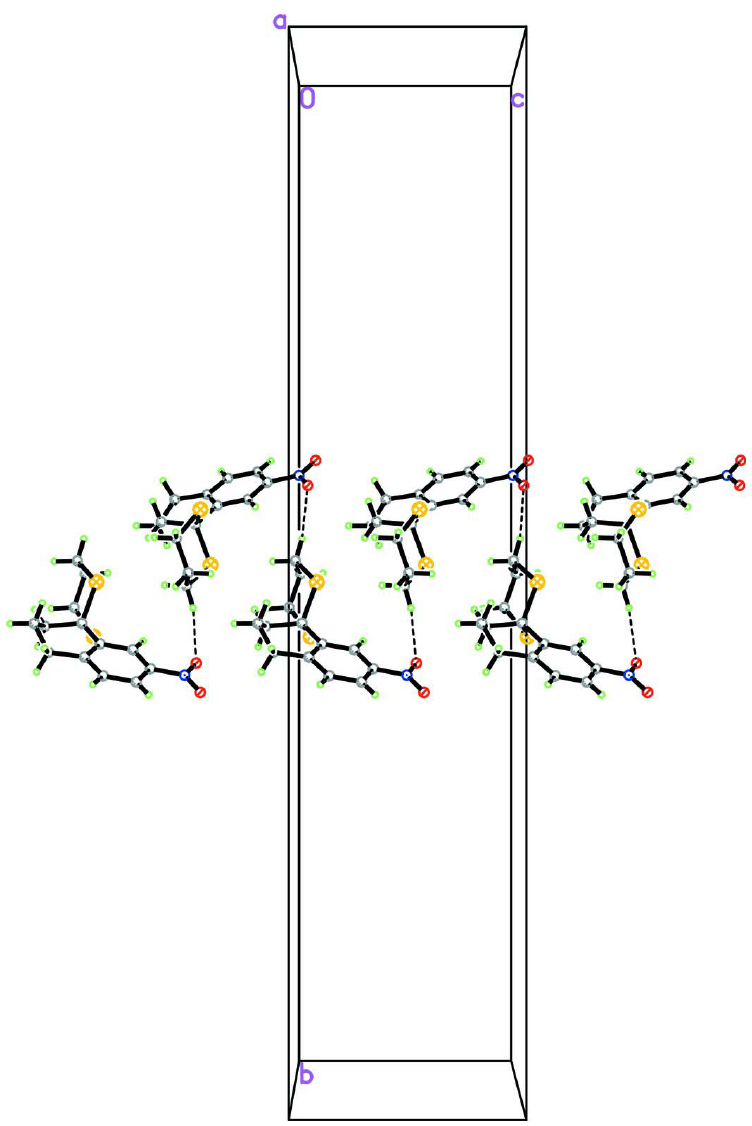
The crystal packing of (I), viewed down the a -axis showing the linking of molecules through intermolecular C—H···O interactions (dashed lines) along the c